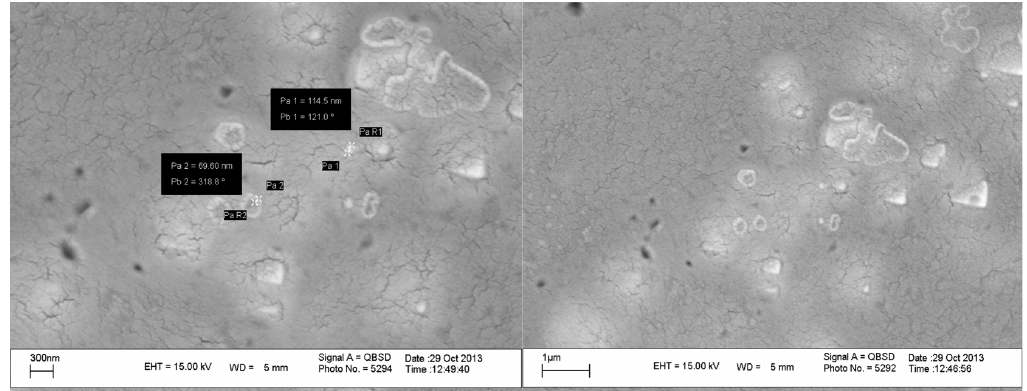
Fig 2. SEM images of prepared nanoliposome